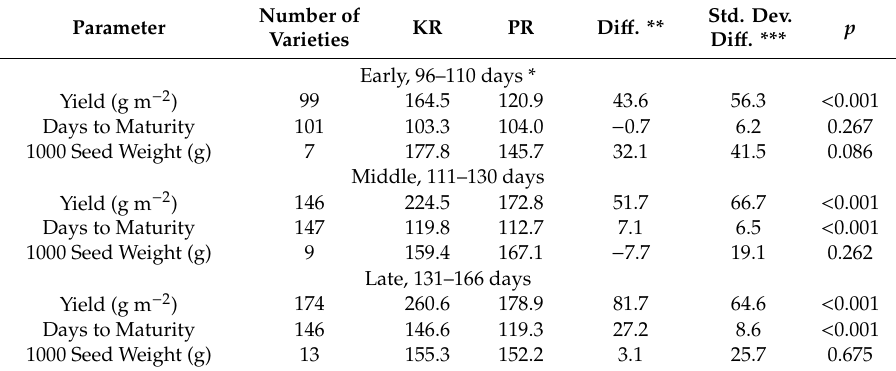
Table 1. Comparison of the soybean maturity groups under the conditions at KR and